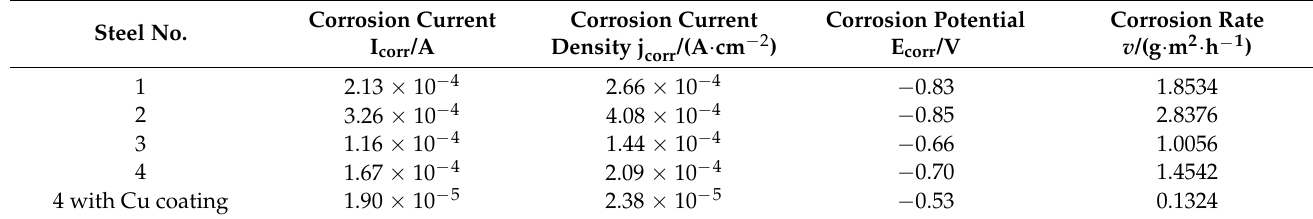
Table 2. Electrochemical parameters of test